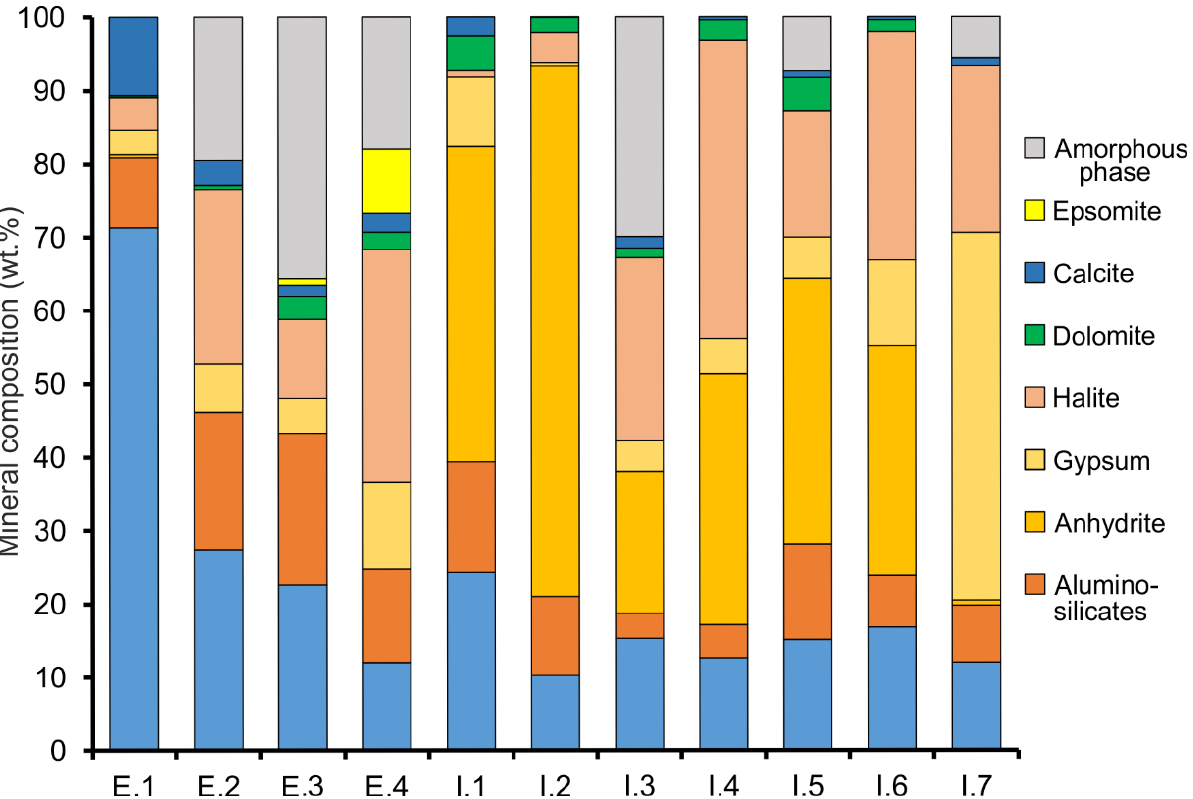
Figure 3. Mineral composition of dusts sampled at the consecutive sites (in wt.%). Quartz. The extremely high content of quartz (SiO 2 ) was observed in the sample E.1 taken outdoors (71 wt.%), which gradually decreased to 12 wt.% at the end of underground dust accumulation (E.4). In the samples from the mine interior (I.1–I.7), the contents of quartz were relatively stable and varied in the range of from 10 to 24 wt.%. Aluminosilicates. This group of minerals, comprising feldspars, plagioclase and potas- sium feldspar, and muscovite, as well as clay minerals (illite, chlorite, and kaolinite) was more abundant in the dusts accumulated at the entrance zone (accounting in average for 15 wt.%), whereas in the inner part of the mine, it accounted on average for 9 wt.%. Only albite (Na[AlSi 3 O 8 ]) and anorthite (Ca[Al 2 Si 2 O 8 ]) represented this group in the sample from outdoors (E.1). Similar to quartz, their content decreased in subsequent dust samples collected in the entrance zone. In the underground dust accumulation (sites E.2–E.4), additionally muscovite (KAl 2 (AlSi 3 O 10 )(F,OH) 2 ), kaolinite (Al 4 [Si 4 O 10 ](OH) 8 ), and chlorite ((Fe,Mg,Al) 6 [(OH) 2 (Si,Al) 4 O 10 ]) were found, while in the inner part of the mine, illite ((K,H 3 O)(Al,Mg,Fe) 2 (Si,Al) 4 O 10 [(OH) 2 ,(H 2 O)]) and muscovite dominated. Albite was present in various proportions in all sampling sites in the mine interior. Calcite. The distribution of calcite (CaCO 3 ) showed a similar trend to the quartz distribution, with a maximum value observed in the sample collected outdoors (E.1, 11 wt.%) and a decrease in content toward the mine interior. The content of calcite inside the mine (sites I.1–I.7) was very low and varied between 0.1 and 2.5 wt.%. Dolomite. The content of dolomite (CaMg[CO 3 ] 2 ) varied across the sampling sites both in the mine entrance zone (0.2–5%) and mine interior (0–5 wt.%). Similarly to halite and gypsum, however, the higher content was observed after the air passed through the shaft, i.e., in an underground dust accumulation, than in the sample taken outdoors. Amorphous phase. Amorphous substances were one of the most prominent components of dust deposited near the underground outlet of air intake shaft and ranged between 36 wt.% (E.3) and 18 wt.% (E.4). Toward the interior of the mine, the elevated